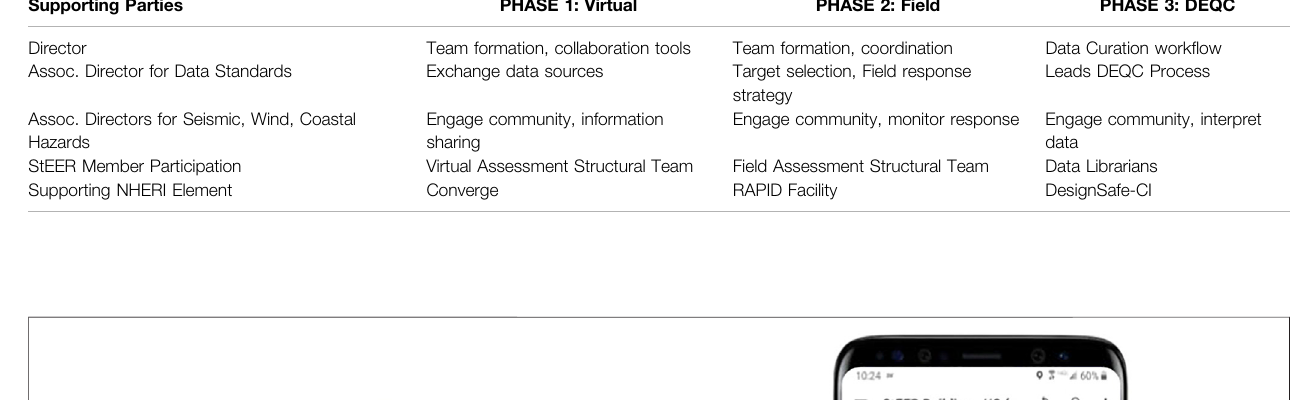
FIGURE 3 | Example of Google Map with target selection for FASTs responding to Hurricane Dorian in the Bahamas, imported as a cached layer into the Fulcrum mobile app, which also visualizes via the color-coded pins the location and global damage rating of assessments conducted by the FAST.